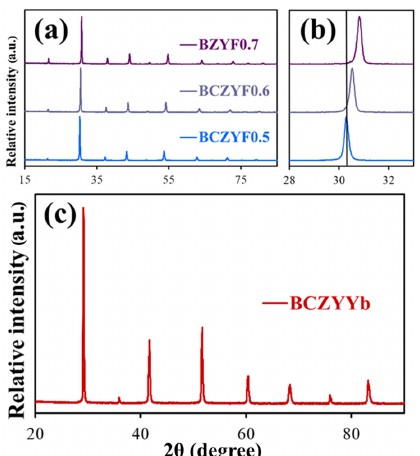
Figure 1. XRD patterns of the ceramic cathode samples after sintering at 1350 °C ( a ), XRD patterns in a narrow angle range ( b ), XRD results for the ceramic electrolyte sample following its sintering at 1450 °C ( c ).